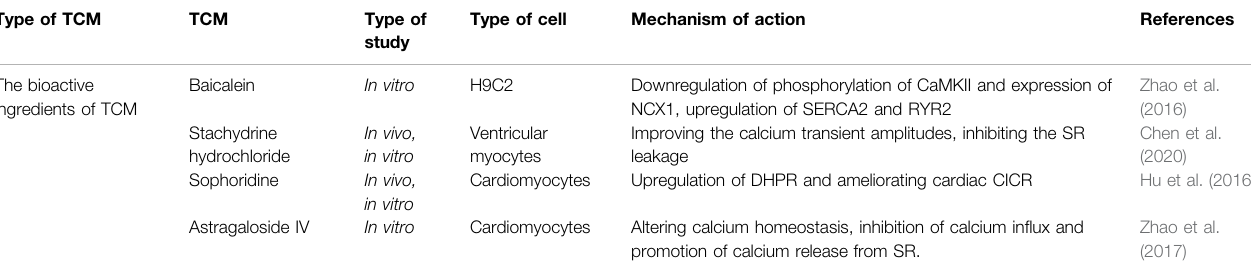
TABLE 4 | The mechanism of TCM in the treatment of heart failure through calcium